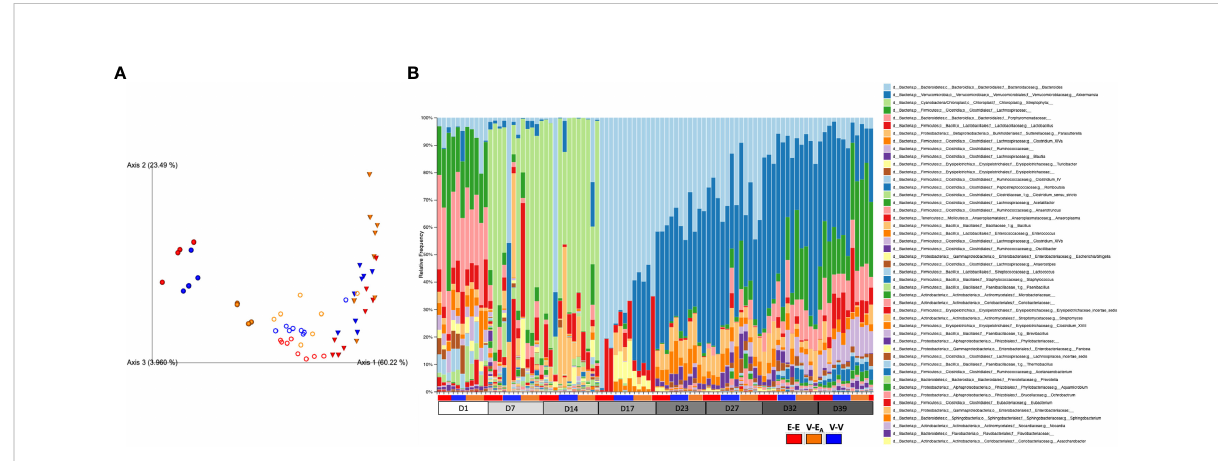
FIGURE 6 Estradiol, antibiotics, and fecal microbiota transplant (FMT) from E2-treated lean mice supplemented with A . muciniphila altered gut microbiota a -diversity and b -diversity in adult female mice. Mice were administered antibiotics for two weeks. From D15, mice received 6 total doses of FMT gavage with (V-E A ) or without (E-E and V-V) A . muciniphila supplementation. (A) Principal component plot showing weighted Unifrac distance for microbial communities during [ ● : D17; o: D23 and D27 aggregate (n=8)] after FMT [ ▽ : D32 and D39 aggregate (n=8)]. (B) Microbiota taxa relative abundances at the genus level, across treatment days. E-E, E2-treated mice receiving FMT from E2 mice; V-V, mice with Veh implants receiving FMT from Veh mice; V-E A , mice with Veh implants receiving FMT from E2-treated mice, supplemented with A muciniphila